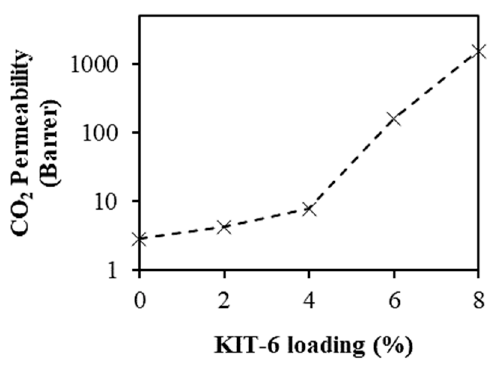
Figure 7. Effect of KIT-6 loading on CO 2 permeability at 5 bar pressure difference and 25 °C.